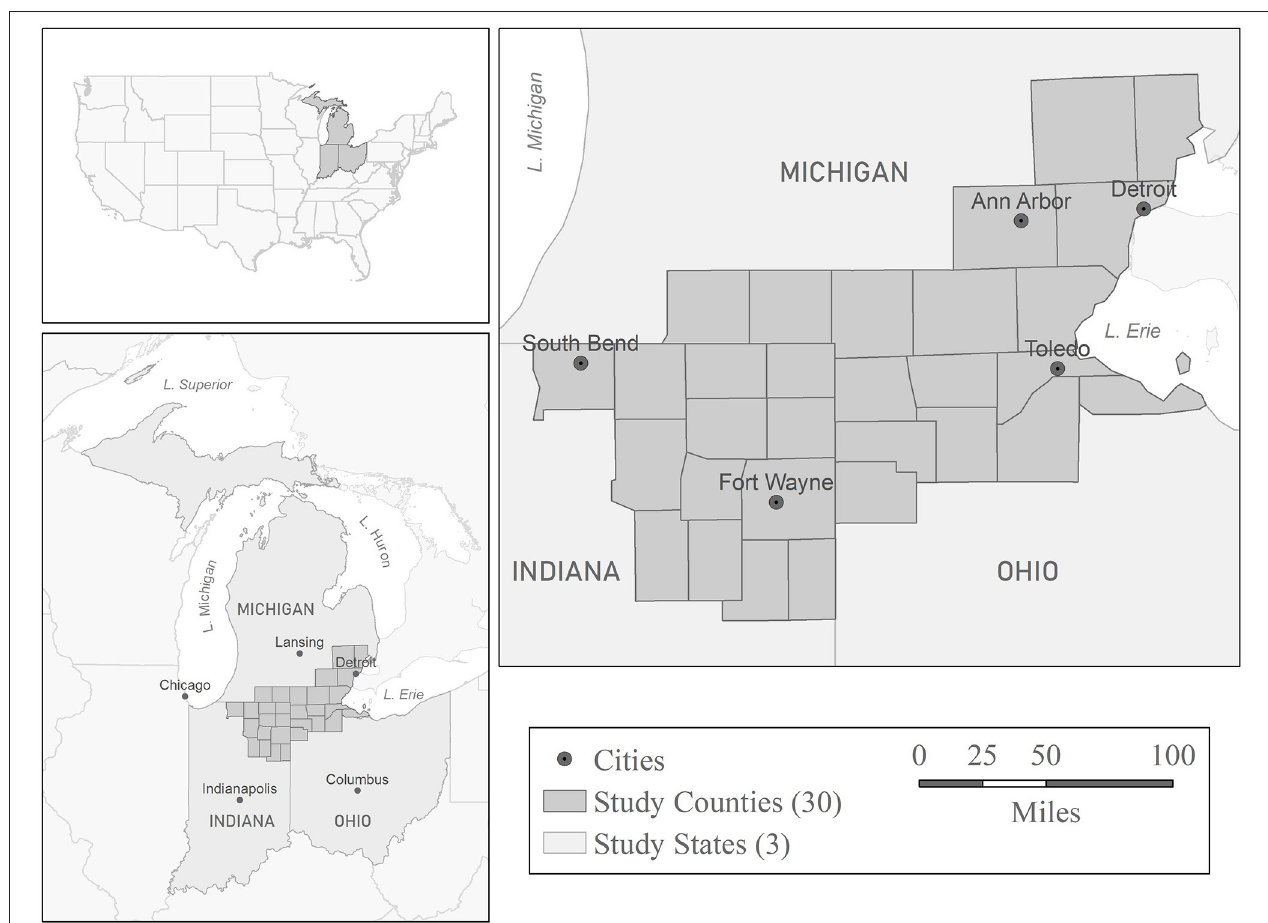
FIGURE 1 | Map of study site in Indiana, Michigan, and Ohio,